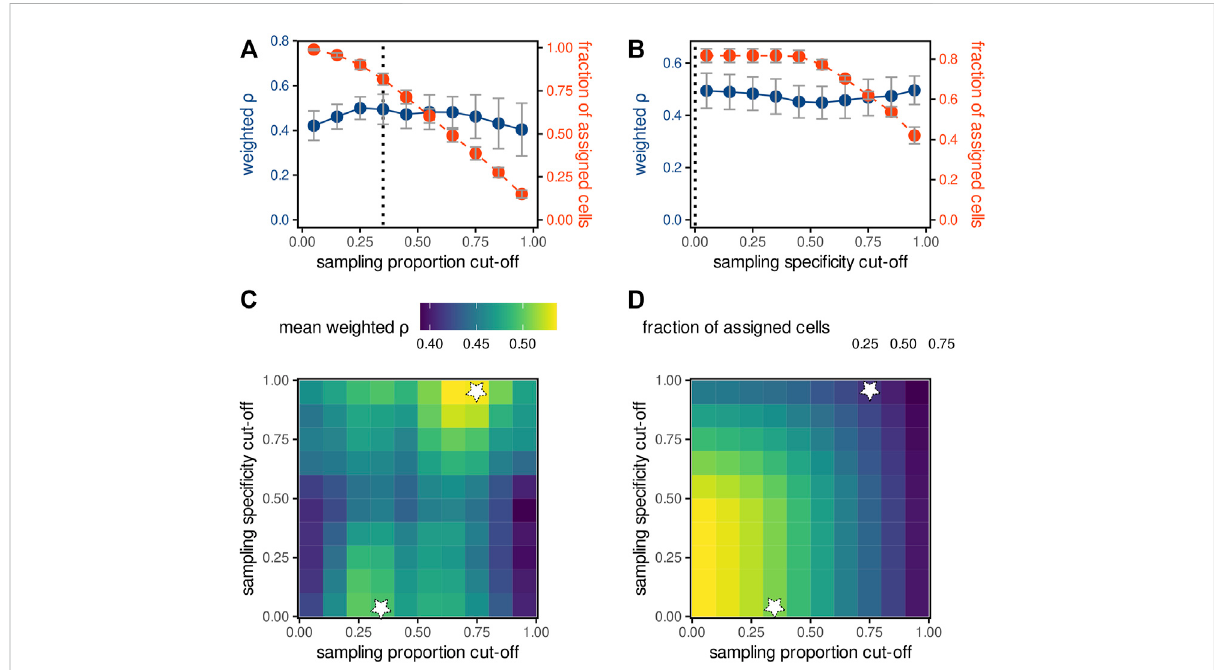
FIGURE 4 Optimising parameters of the weighted average pixel-cell deconvolution. (A,B) The effect of increasing the sampling proportion cut-off (A) or sampling speci fi citycut-off (B) onthemeandensity-weightedSpearmancorrelation ρ (blue)between fl uorescenceandMSintensitiesof fl uorescein (deconvolution method WA, m/z tolerance of 4 ppm) as well as the fraction of cells with assigned MS-signals (red). Data points indicate the mean values and standard deviation of the 6 replicates, dashed lines the optimal values. (C,D) Heatmaps of mean weighted Spearman correlation (C) or fraction of assigned cells (D) as function of sampling (x-axis) or speci fi city (y-axis) proportion cut-offs. White stars indicate the values maximising the mean weighted correlation ρ